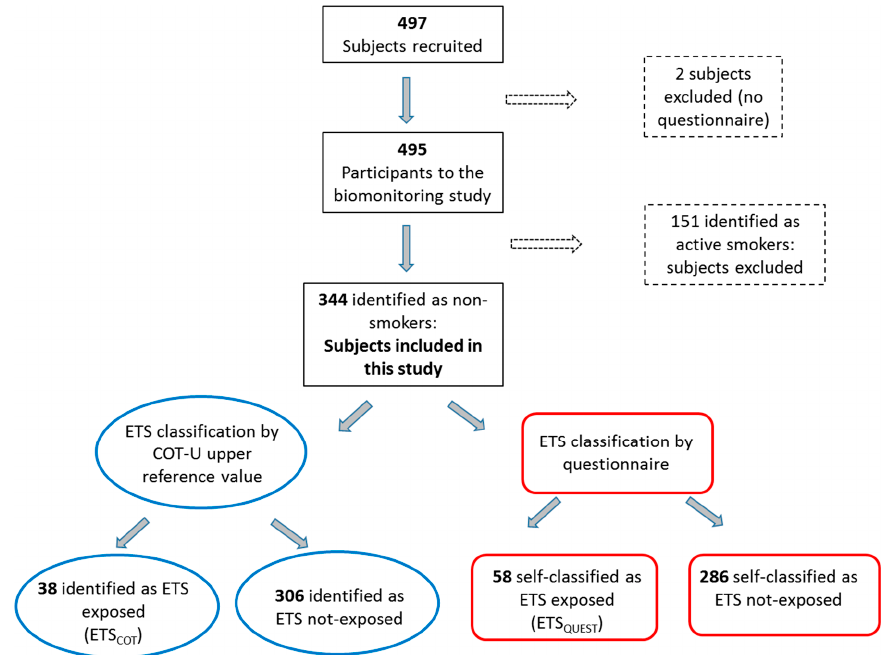
Figure 1. Participant flow-chart.